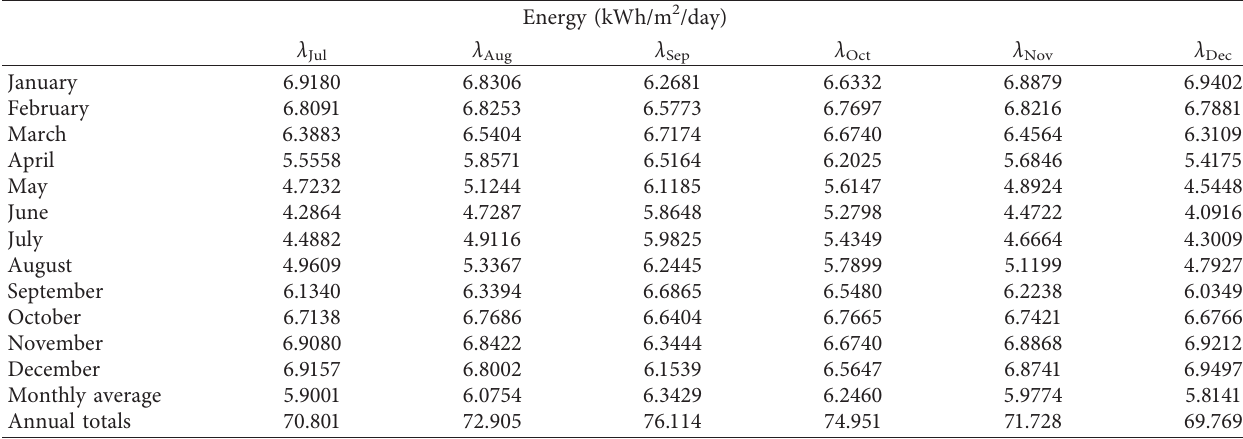
Table 4: Average daily solar energy outputs for July to December tilt